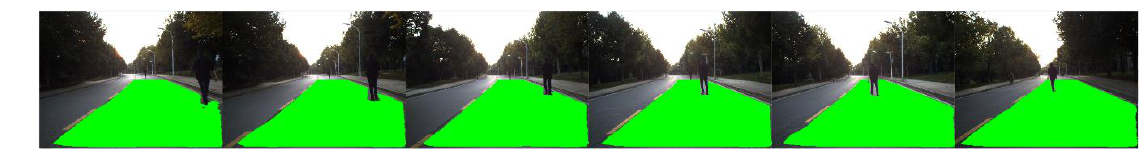
Figure 12. Detection results in the presence of single, continuously-moving pedestrian.